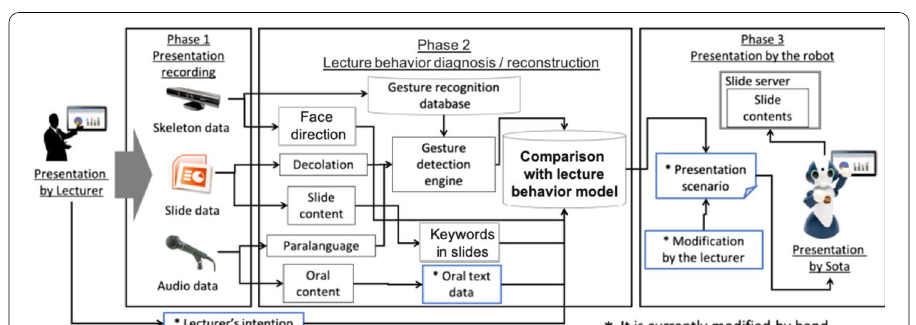
Fig. 5 Framework for reconstructing lecture